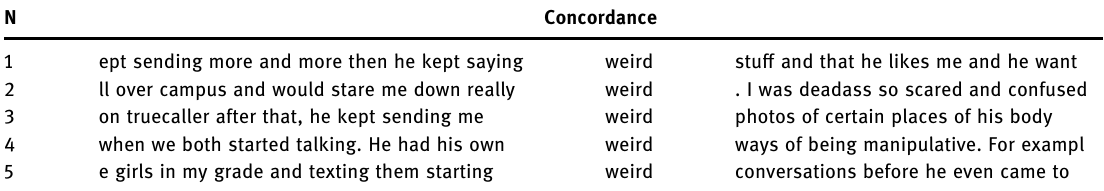
Table 19: Concordance lines for weird